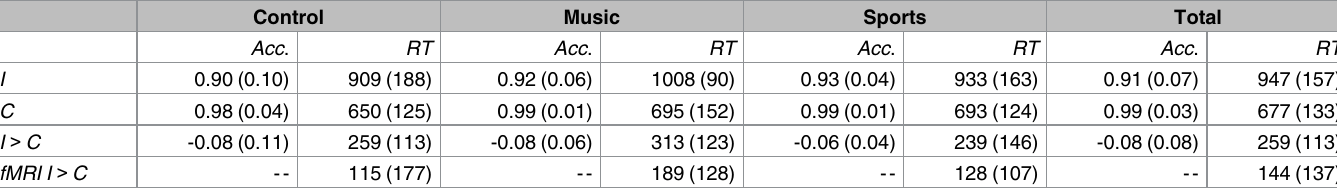
Table 2. Mean accuracyand response time during both the behavioral and fMRI Color-Word matching Stroop task.